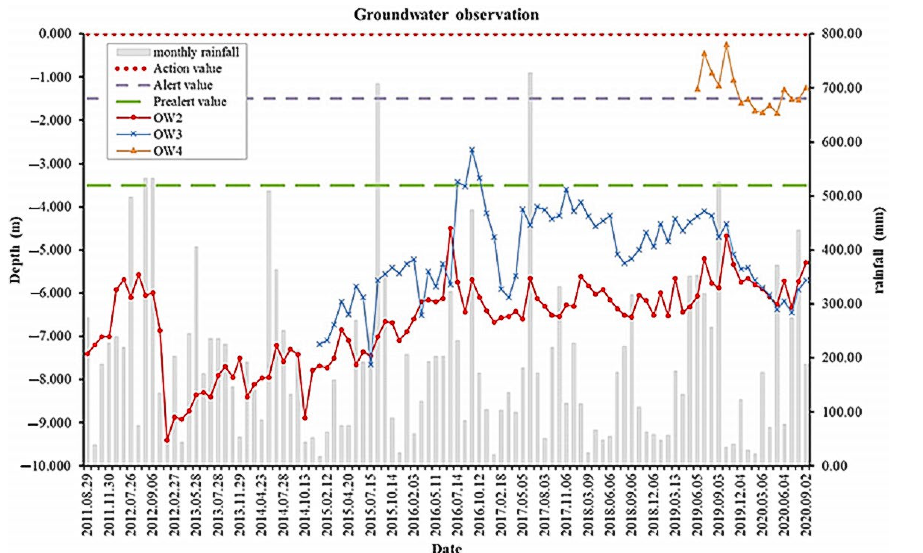
Figure 7. Monitoring results of water level changes in the side slope well with time